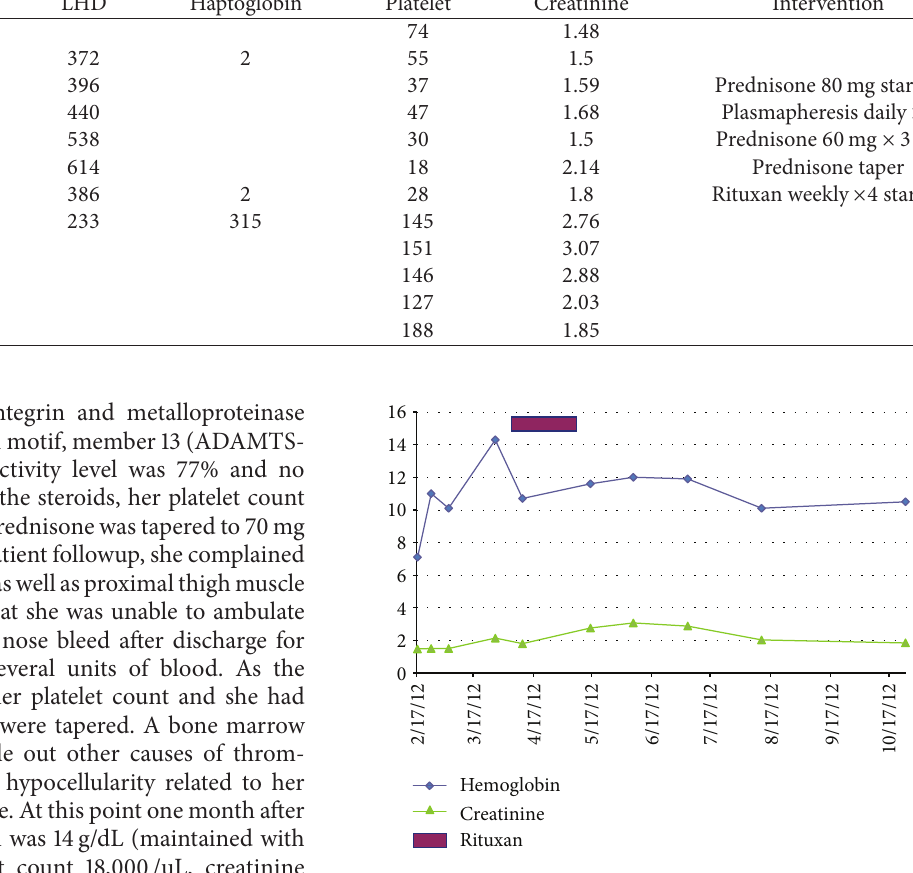
Figure 1: Hemoglobin and creatine response with rituximab inter-